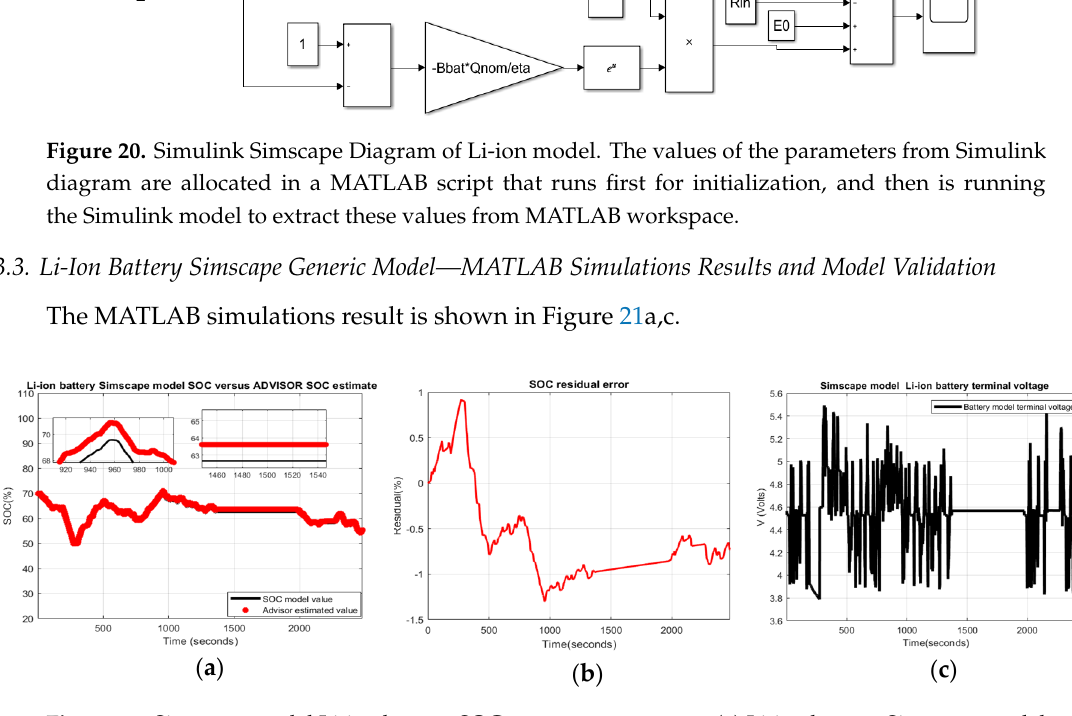
Figure 21. Simscape model Li-ion battery SOC accuracy assessment ( a ) Li-ion battery Simscape model SOC versus ADVISOR SOC estimate; ( b ) SOC residual; ( c ) terminal output voltage.